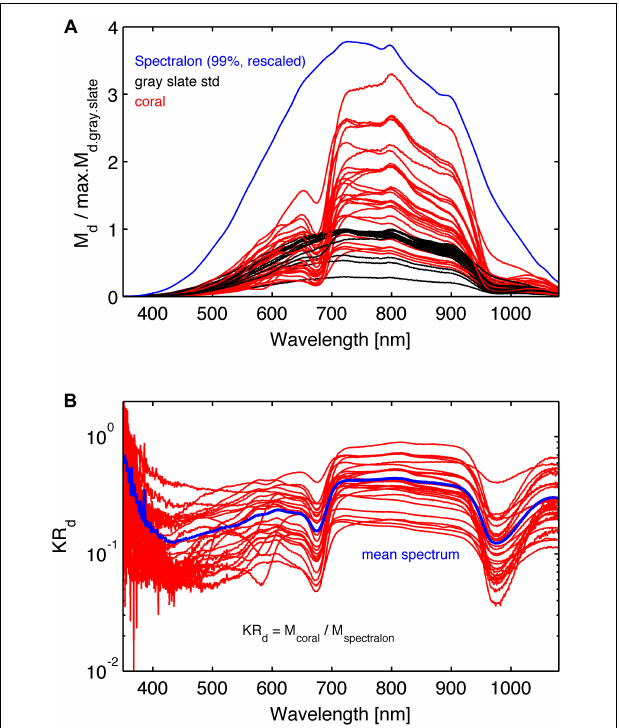
FIGURE 4 | (A) The raw spectra: red lines are the coral reflected light spectra M d . coral ( λ ), black lines are reflected light spectra, M d . gs ( λ ), from the gray reflectance standard spectra, and the blue line is reflected light spectrum, M d . sp ( λ ), from the 99% Spectralon reflection standard scaled arbitrarily. The coral and gray reference spectra were normalized by the maximum reflection in the gray reference spectrum for each coral. (B) Normalized reflectance spectra, KR d ( λ ) (see Eq. 3). The blue line is the mean spectrum of the 26 coral